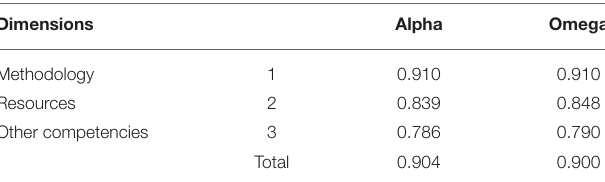
TABLE 2 | Reliability indices.